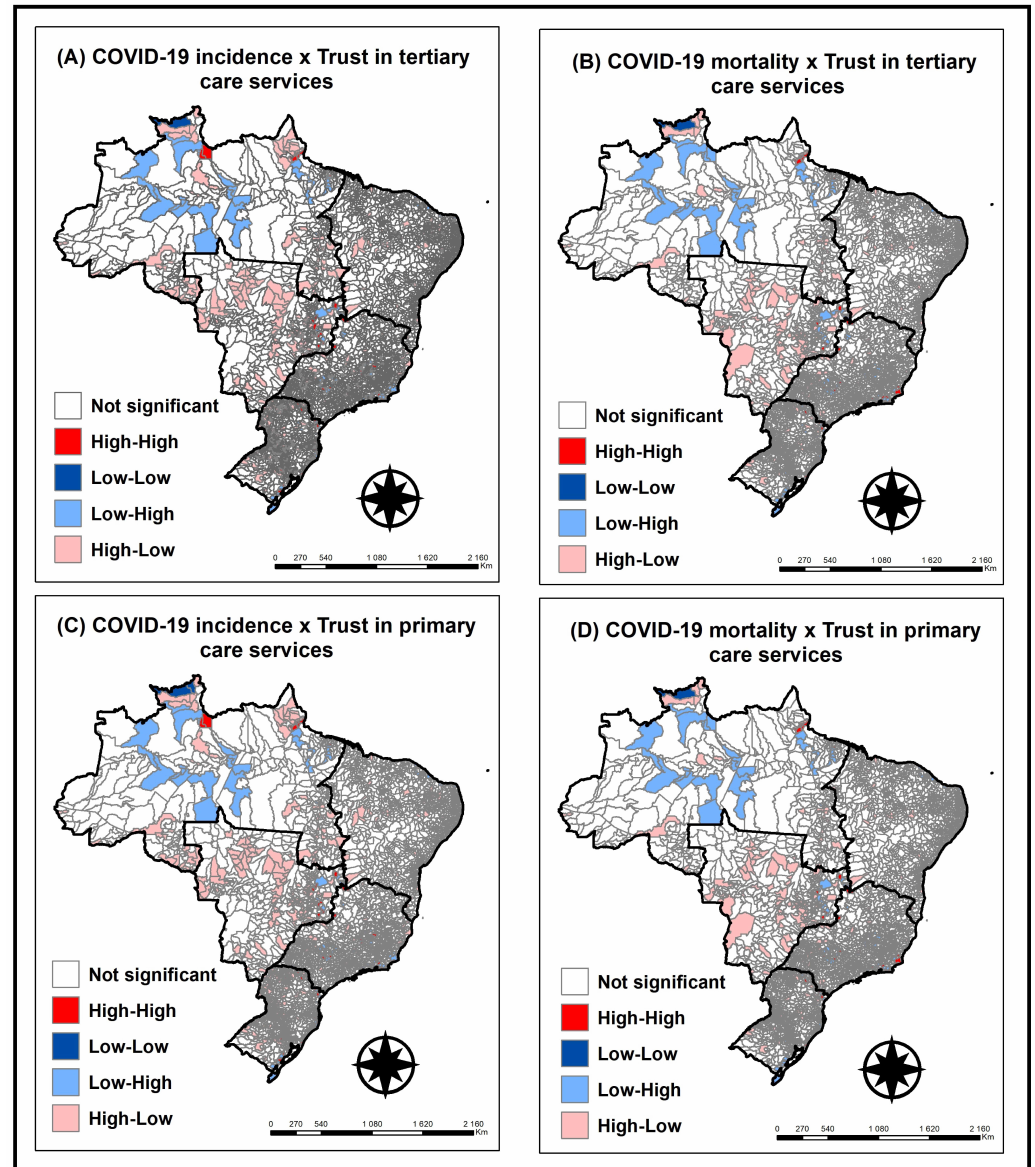
Figure 1. ( A ) Bivariate spatial dependence analysis (Moran index) between the COVID-19 incidence rate and the population’s level of trust in tertiary care health services. ( B ) Bivariate spatial dependence analysis (Moran index) between COVID-19 mortality rate and the population’s level of trust in tertiary care health services. ( C ) Bivariate spatial dependence analysis (Moran index) between COVID-19 incidence rate and the population’s level of trust in primary care health services. ( D ) Bivariate spatial dependence analysis (Moran index) between COVID-19 mortality rate and the population’s level of trust in primary care health